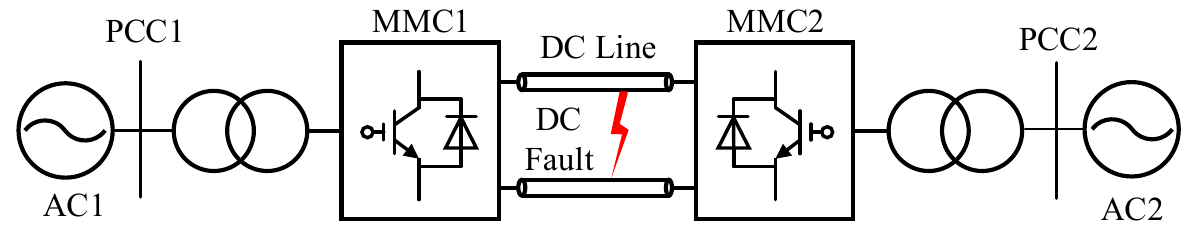
Figure 13. Double ‐ ended MMC–HVDC system. Figure 13. Double-ended MMC–HVDC